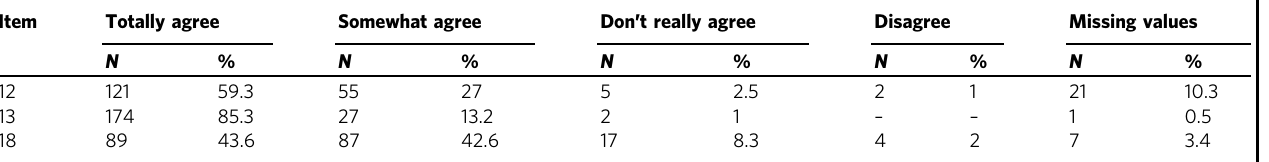
Table 8 Treatment of subject in